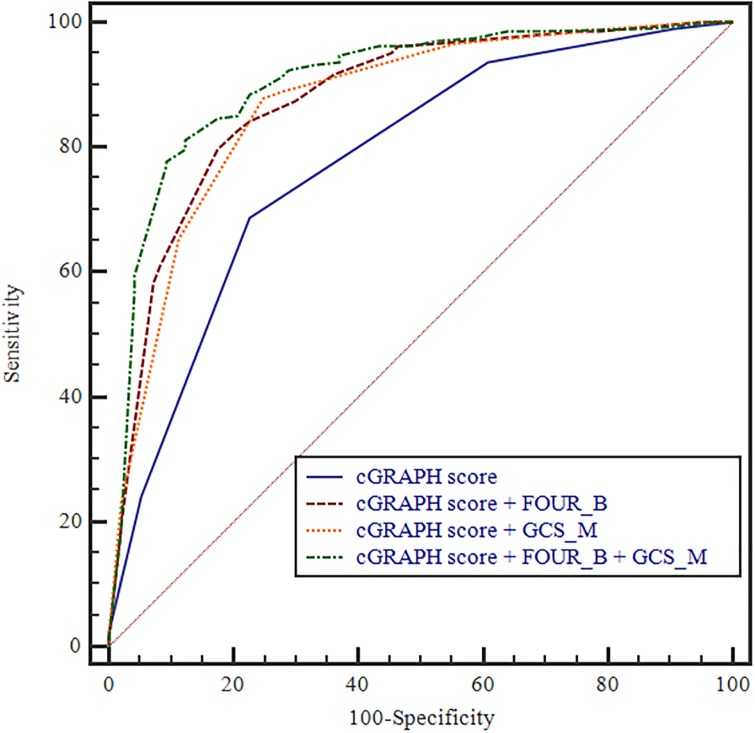
Prognostic value of C-GRApH score for the prediction of poor neurologic outcome after CA.[1] C-GRApH score (AUC 0.779, 95% CI 0.728–0.824); [2] C-GRApH score with FOUR_B (AUC 0.877, 95% CI 0.835–0.912); [3] C-GRApH score with GCS_M (AUC 0.869, 95% CI 0.826–0.905); [4] C-GRApH score with FOUR_B and GCS_M (AUC 0.906, 95% CI 0.868–0.936).